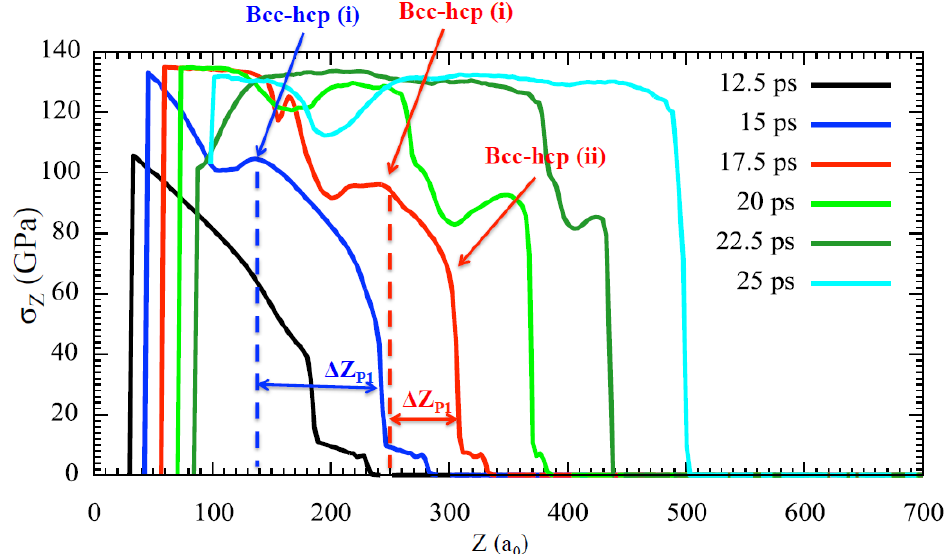
Figure 7. Stress profiles at successive times showing the evolution of the ramp compression, which steepens into a shock wave during its propagation. The width of the P1 wave is used to evaluate the plastic deformation strain rate. The bcc–hcp phase transformation occurs either under ramp compression on a ~100 GPa order scenario (i) or upon an increase in the strain-rate scenario (ii).